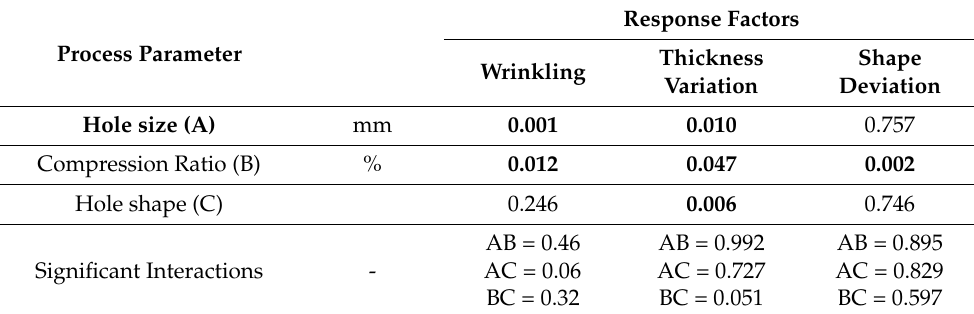
Table 3. p -value of the investigated parameters and the two-factor interactions. Values in bold indicate significant parameters.